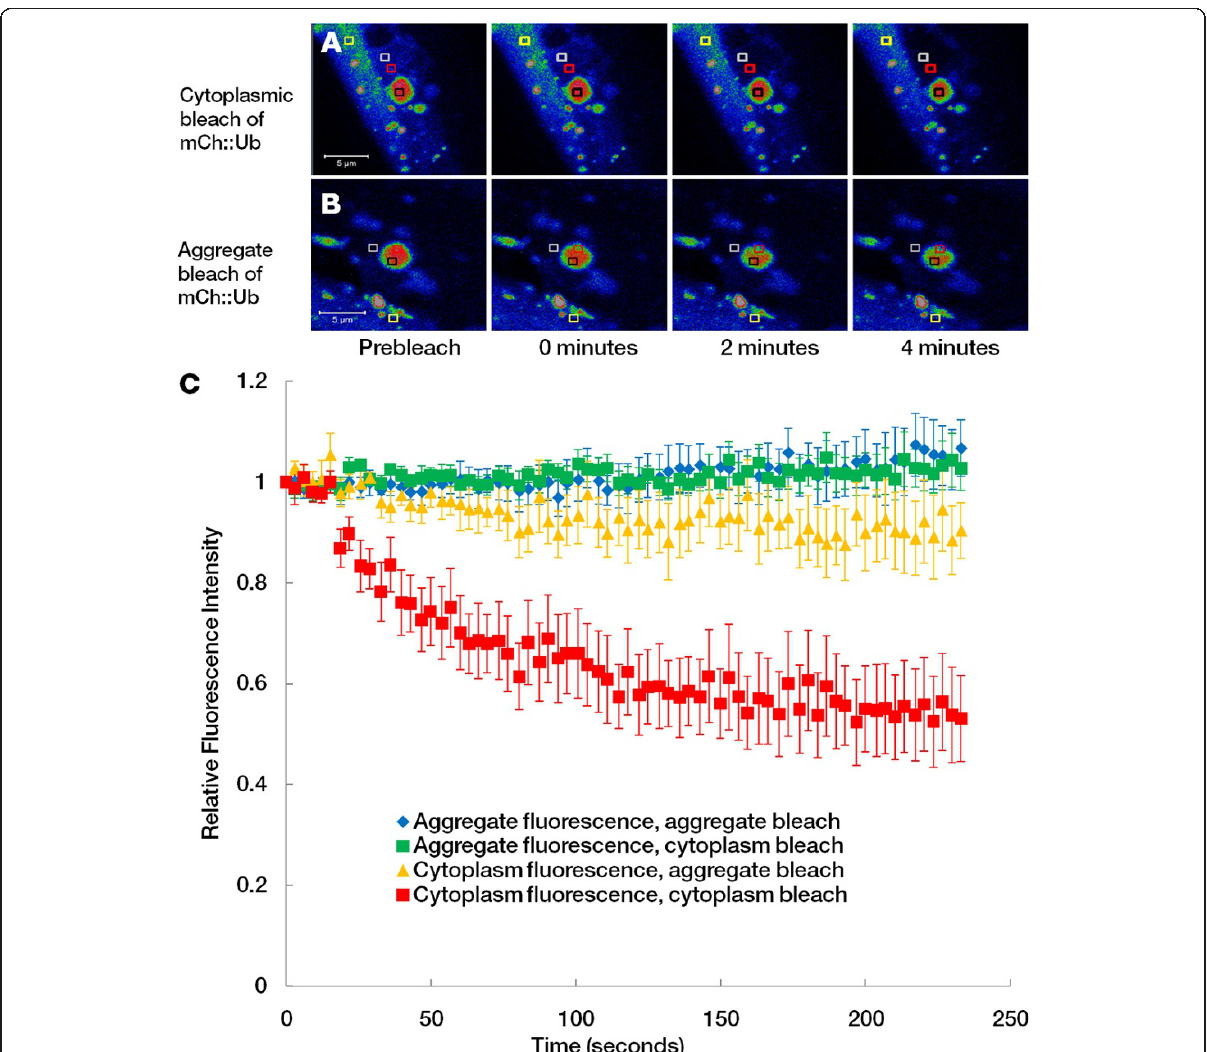
Figure 7 FLIP analysis of mCherry::ubiquitin and Q82::GFP . Worms co-expressing an mCherry::ubiquitin fusion protein with Q82::GFP were subjected to FLIP analysis of the mCherry::ubiquitin protein to study mobility of ubiquitin. Fluorescence intensity is indicated by a heat map of mCherry::ubiquitin prior to bleaching and at various times after commencement of repeated bleach pulses. Red squares indicate regions where bleach pulses were directed, black and white squares indicate regions that were quantitatively analyzed for fluorescence loss, and yellow squares indicate regions in non-bleached cells that were used to control for acquisition photobleaching. Separate experiments were carried out in which bleaching was directed to the cytoplasm ( A ) or the aggregate of Q82::GFP ( B ). A quantitative analysis ( C ) was carried out to analyze fluorescence loss over time. Results indicate no loss of mCherry fluorescence in aggregates when bleaching was directed to either a separate region within the aggregate itself (blue diamonds) or an area in the cytoplasm. The loss of fluorescence in the cytoplasm when a region within the cytoplasm was bleached indicates the effectiveness of the bleaching protocol (red squares), while the limited loss of fluorescence in the cytoplasm when a region within the aggregate was bleached indicates the limited access of mCherry::ubiquitin to the Q82::GFP